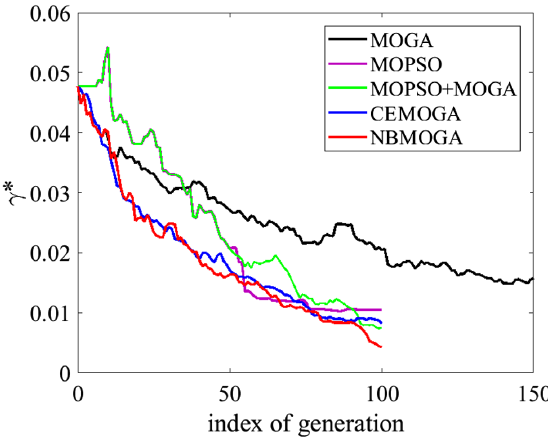
FIG. 12. Evolution of γ (cid:3) over generations (1 – 150 generations for the standard MOGA and 1 – 100 generations for the other four methods) for the DA and TL optimization of the HEPS. γ (cid:3) measures the average distance between the obtained nondomi- nated solutions and the best front.